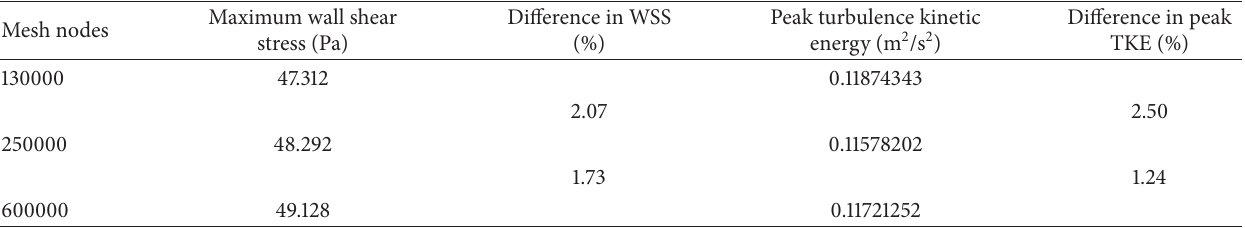
Figure 3: Tetrahedral coarse, medium, and fine meshes generated from 3D SolidWorks of the lumen for Type I. Table 1: Mesh independency test results comparing the maximum axial WSS and peak TKE values between different meshes for Type I: